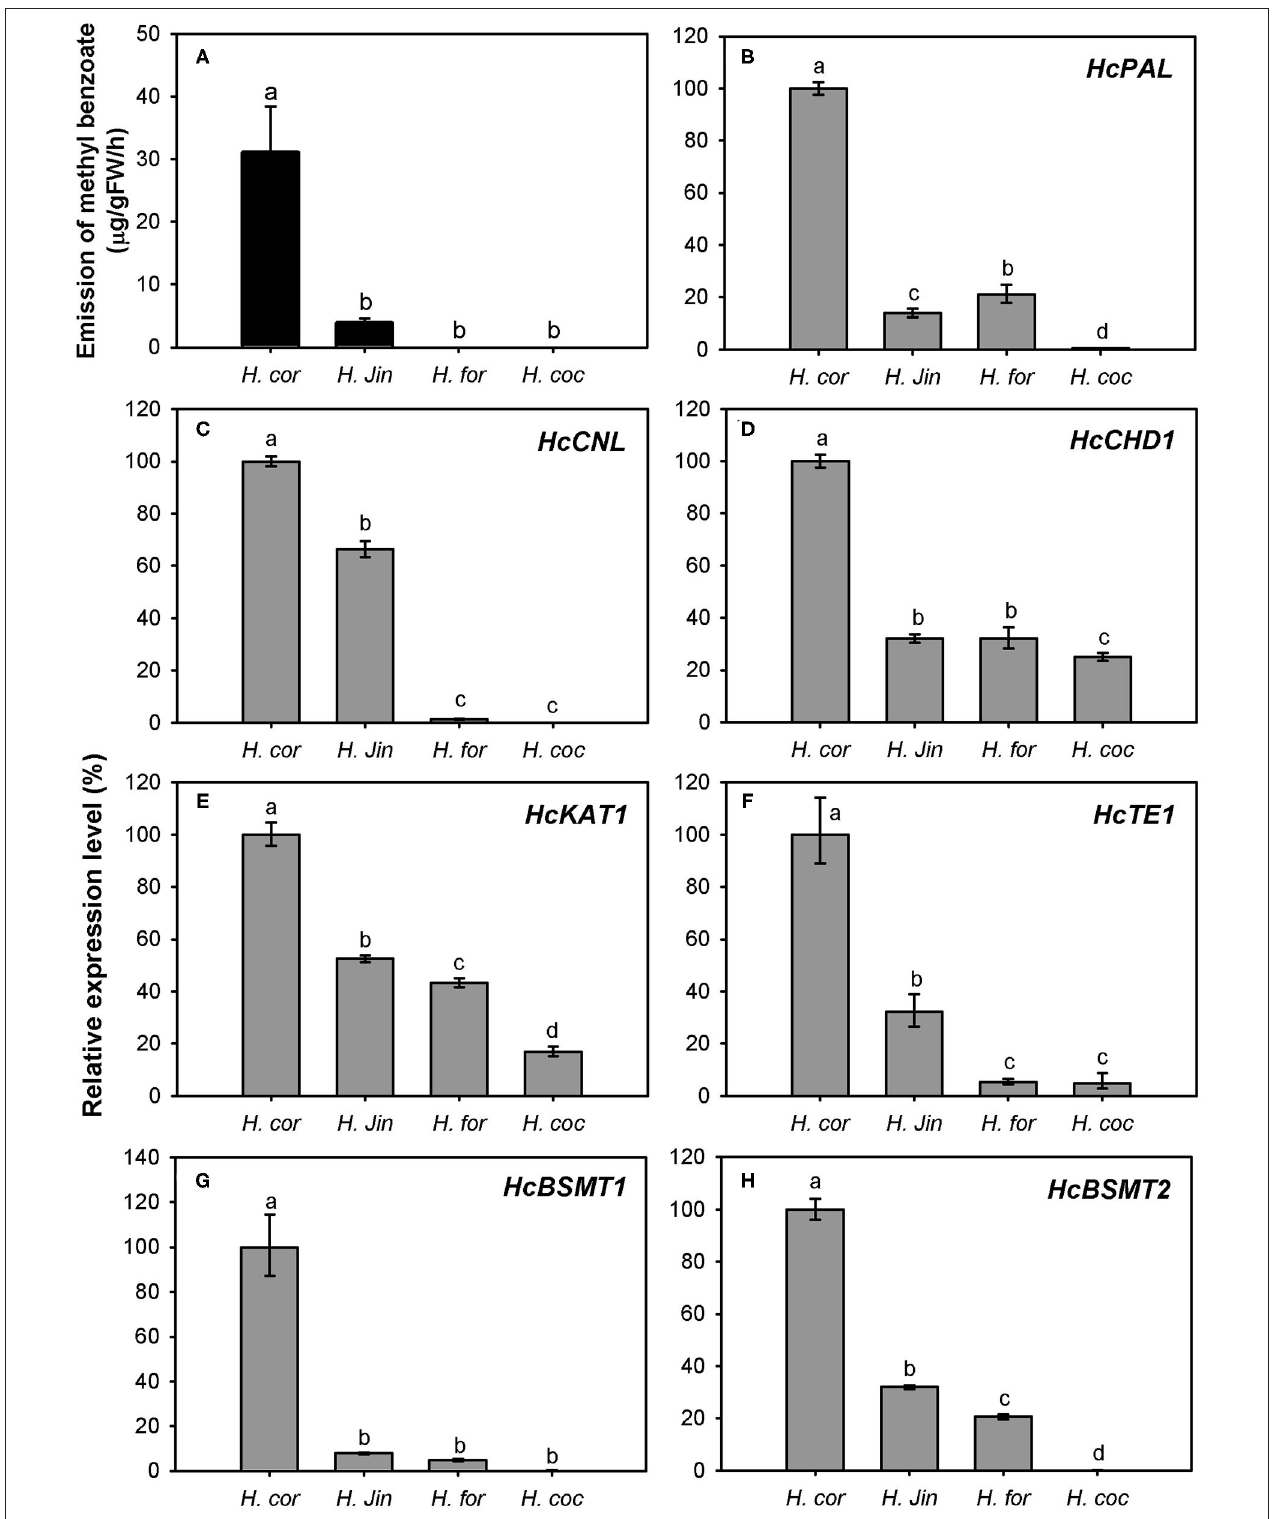
FIGURE 9 | Methyl benzoate emission (A) and related biosynthetic genes expression analysis (B – H) in flowers of four Hedychium species. Relative transcription level of tissue with highest expression quantity was set to 1 (100%). Error bars indicate the calculated maximum and minimum expression quantity of three replicates. Different lowercase letters labeled on bars indicate statistically significant differences at the level of P < 0.05. H. cor : H. coronarium (scent); H. Jin : H. “Jin” (scent); H. for : H. forrestii (scentless); H. coc : H. coccineum (scentless).